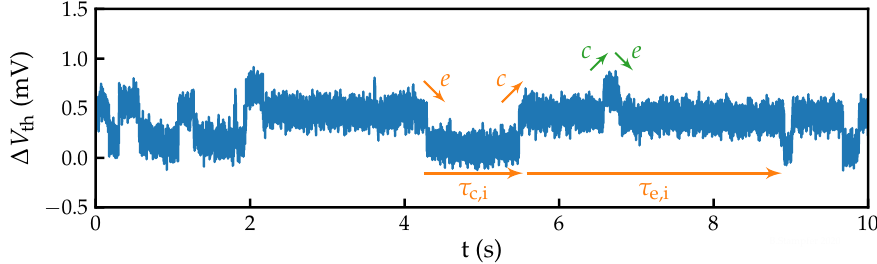
Figure 3. Random telegraph noise traces recorded on a device with T s = 100µs. Two active defects with similar step heights are clearly visible. The arrows show steps and dwelling times linked to charge capture (c) and charge emission (e) events of the